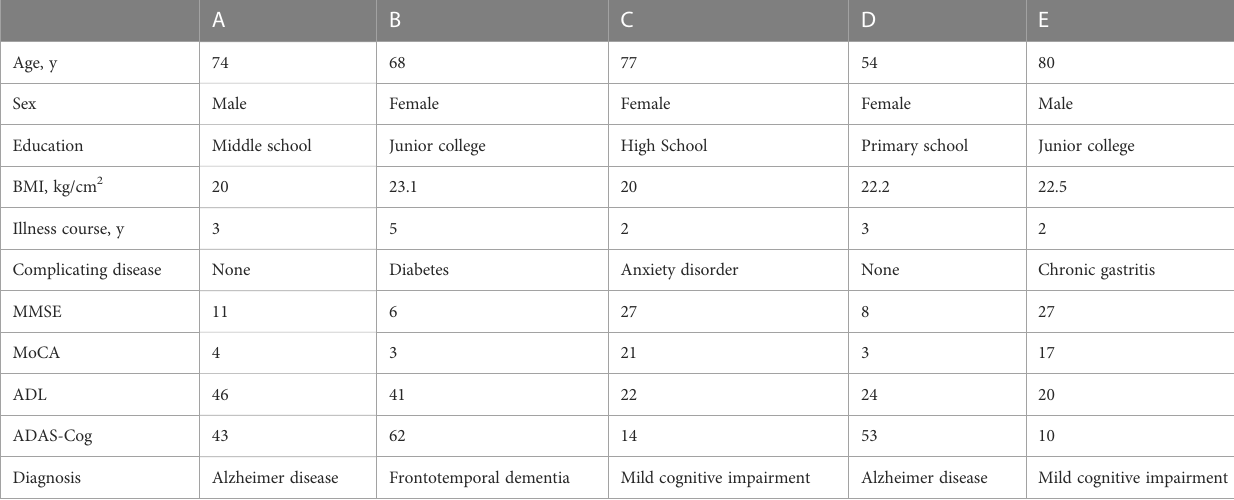
TABLE 1 Basic information of patients with cognitive